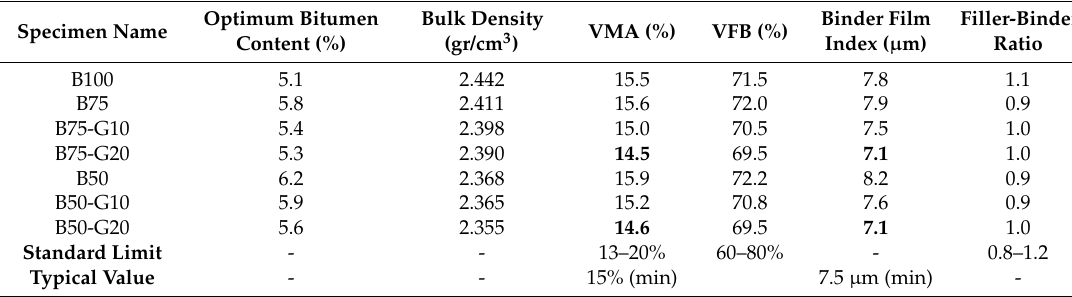
Table 9. Volumetric properties of asphalt mixtures at optimum bitumen content.